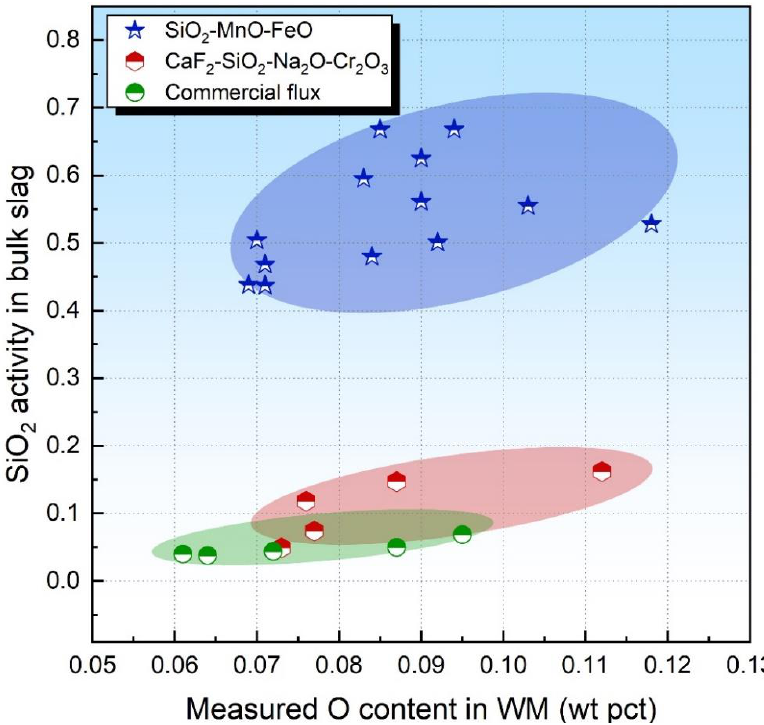
Figure 1. SiO 2 activity in bulk slag as a function of measured O content in WM.